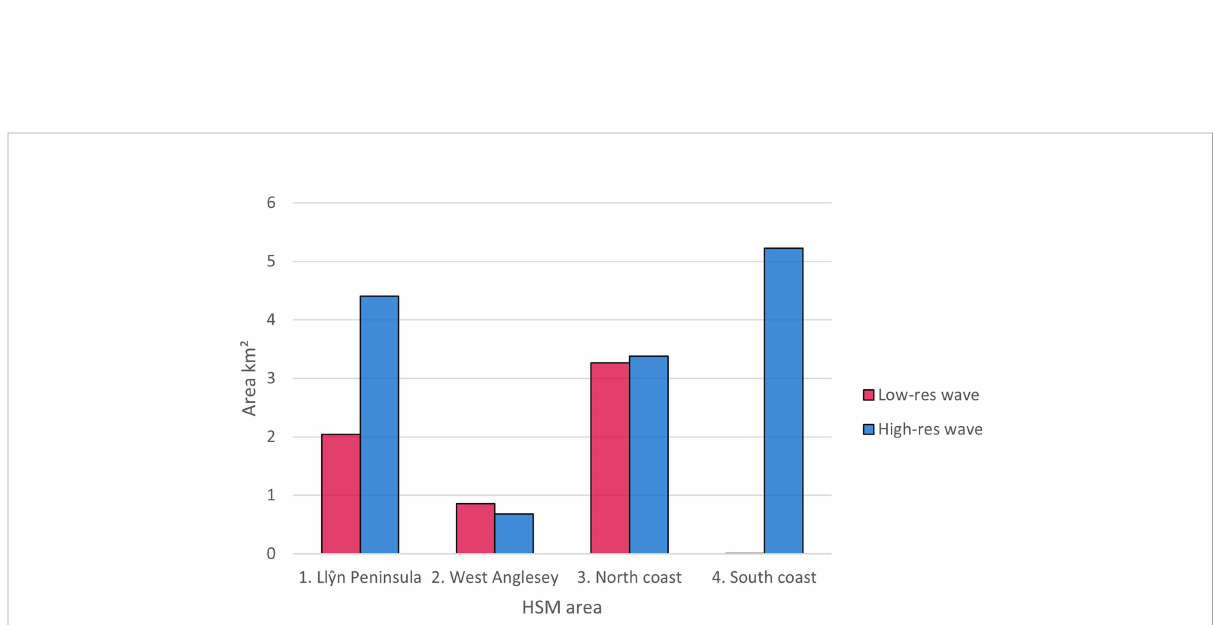
FIGURE 7 Difference in area (km 2 ) predicted as suitable using ≥ 0.6 probability threshold for ensemble models using lower resolution wave energy data and high-resolution wave height